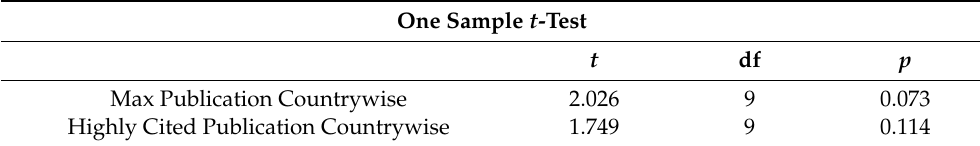
Table 6. One-sample t -test of top ten countries in all and highly cited paper